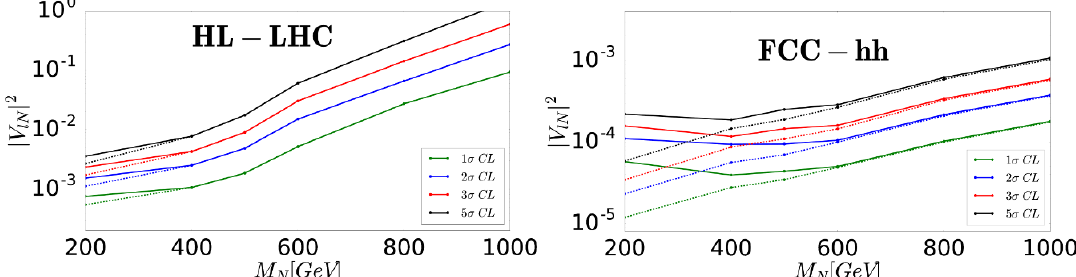
Figure 7 . Same as (cid:12)gure 6, including the 1, 2, 3 and 5- (cid:27) median expected limits on the parameter j V lN j 2 for j V lN j 2 = j V eN j 2 = j V (cid:22)N j 2 and j V (cid:28)N j 2 = 0, at the HL-LHC (left) with 3 ab (cid:0) 1 luminosity p and at the FCC-hh (right) with s = 100 TeV and 20 ab (cid:0) 1 luminosity. In both panels the solid (dashed) line denotes that a 10% (0%) systematic uncertainty on the background is